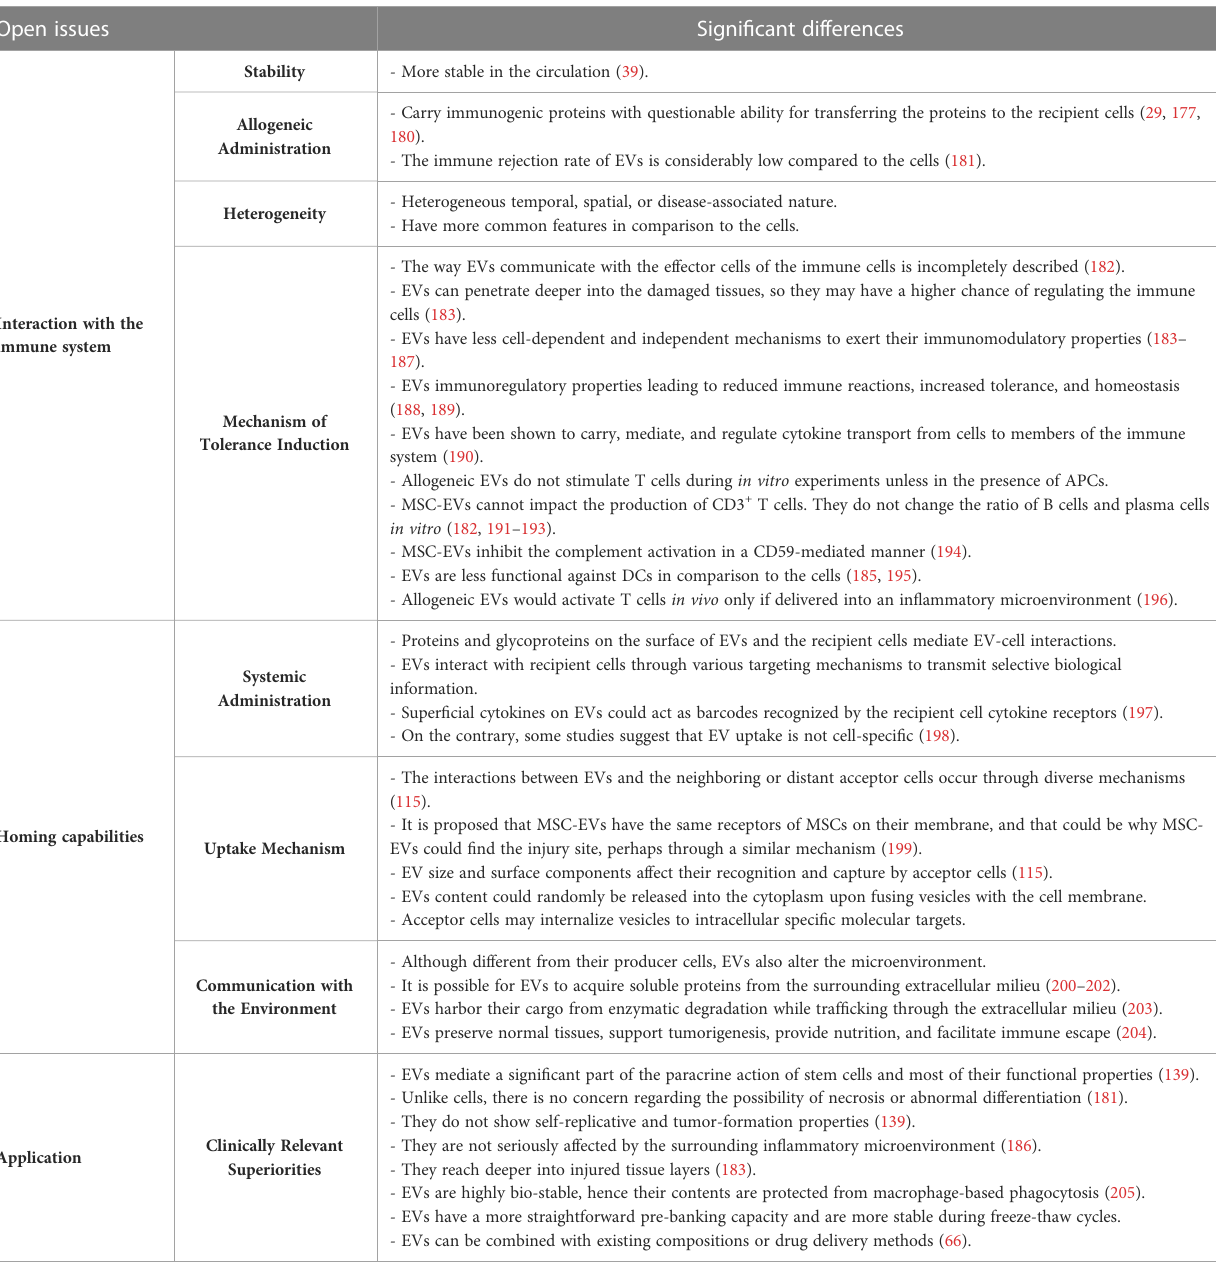
TABLE 1 EVs have differences in comparison to their producer